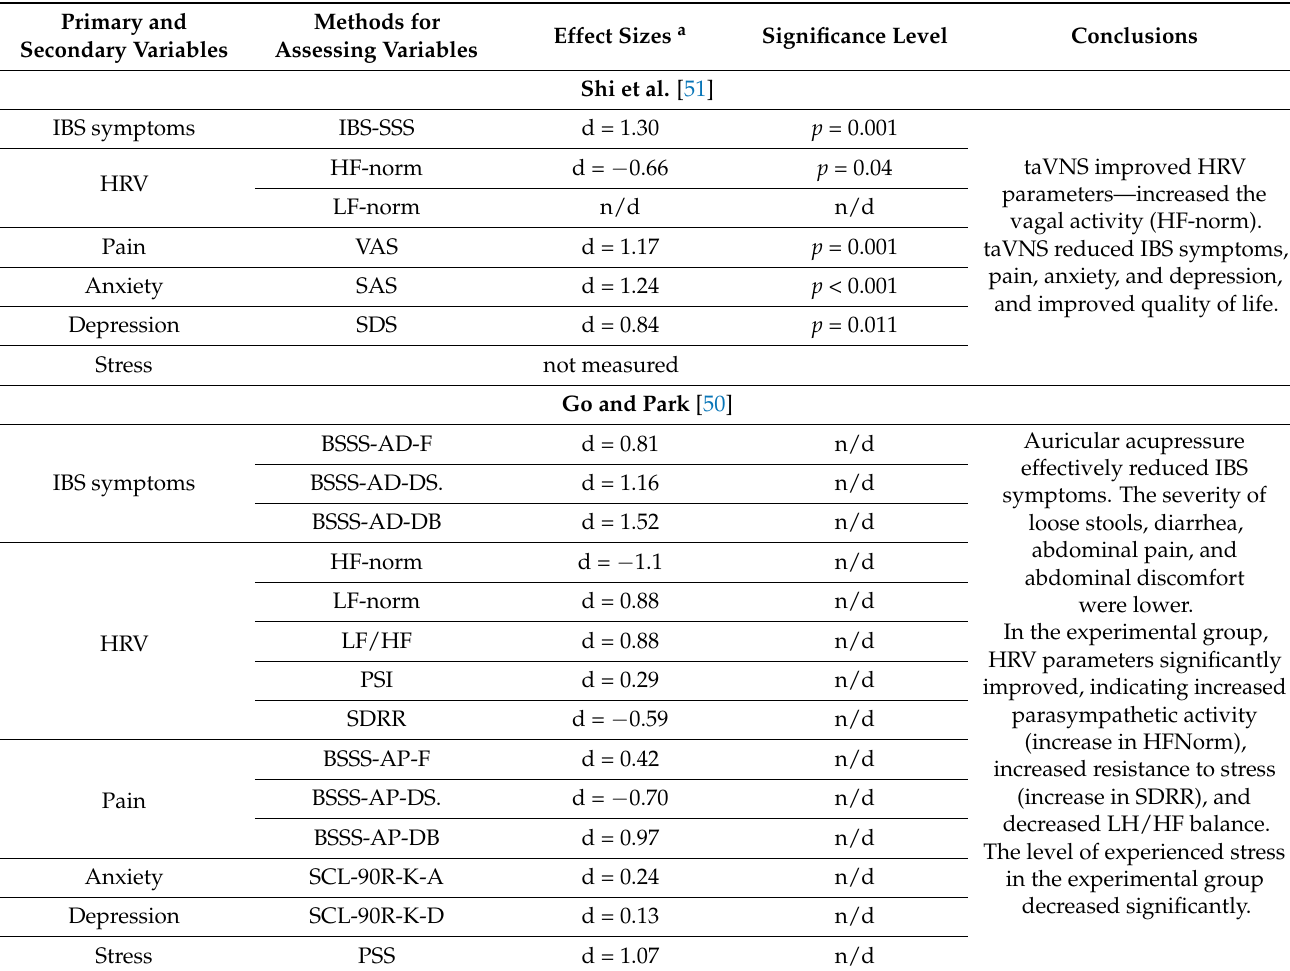
Table 4. Results and conclusions of the studies included in the review. Comparison of the size of effects for primary and secondary